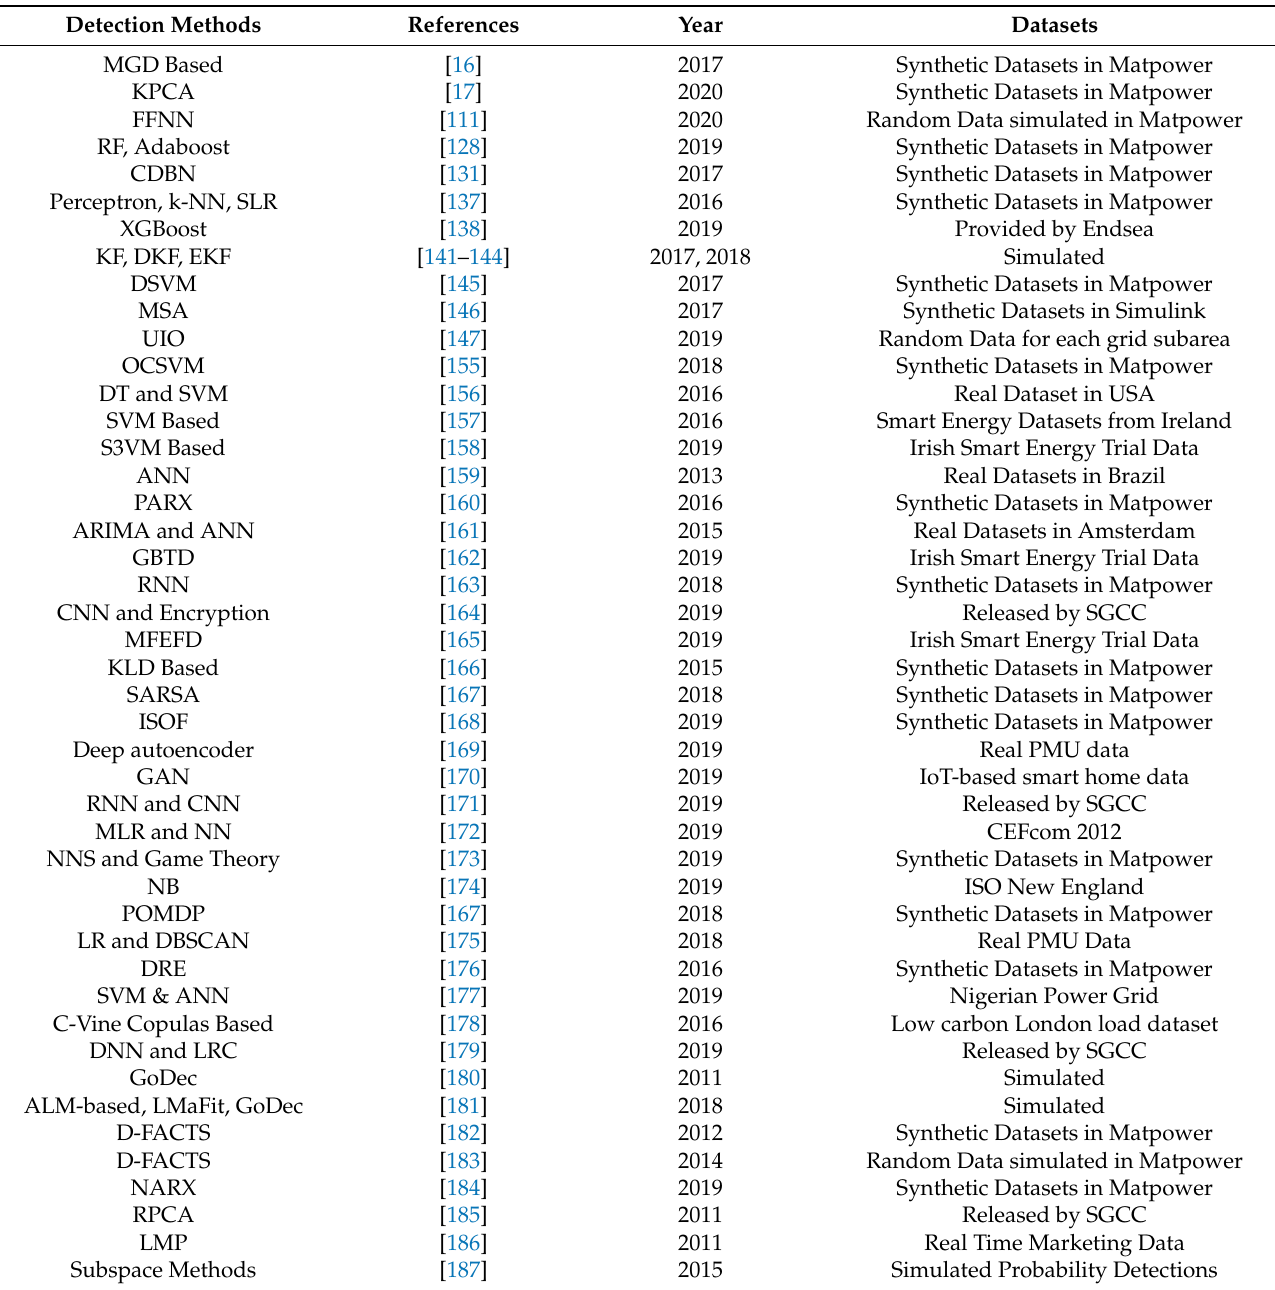
Table 3. Overview of FDIA detection methods in the